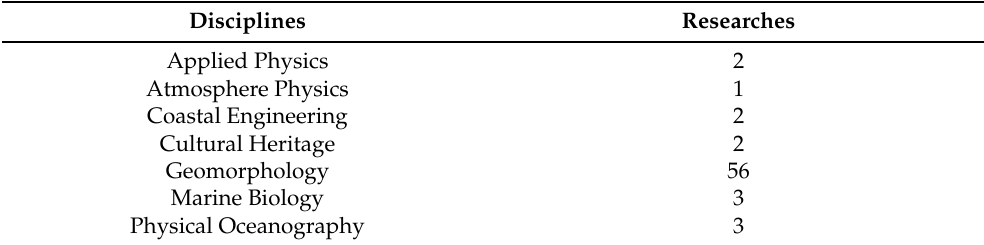
Table 2. Scientific disciplines of the authors.